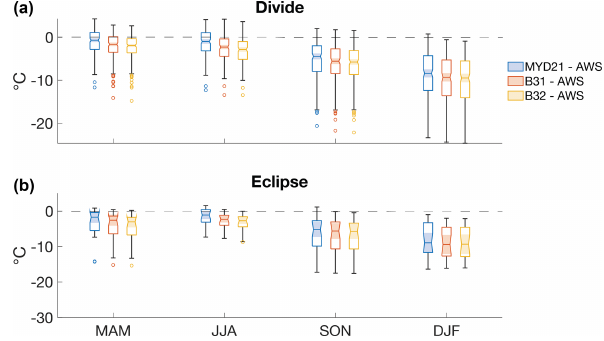
Figure 7. Offsets of MODIS surface temperatures, MODIS band 31 (B31) brightness temperatures and MODIS band 32 (B32) bright- ness temperatures from AWS measurements at Divide and Eclipse. Horizontal dashed lines indicate where MODIS temperatures and AWS temperatures are equivalent. At Divide, spring and summer offsets are smaller in the final surface temperatures than in bright- ness temperatures (95% confidence interval); fall and winter offsets have no difference between final surface temperatures and bright- ness temperatures (95% confidence interval). Surface and bright- ness temperatures show no significant difference from each other at Eclipse in any season due to smaller sample sizes.